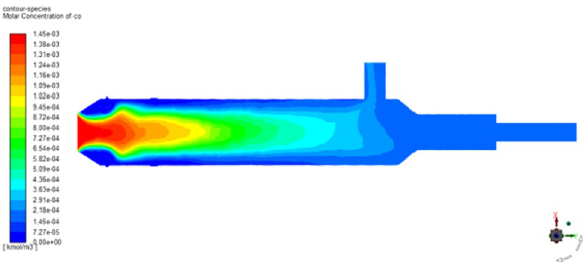
Fig. 9 Distribution of CO concentrations in the second combustion